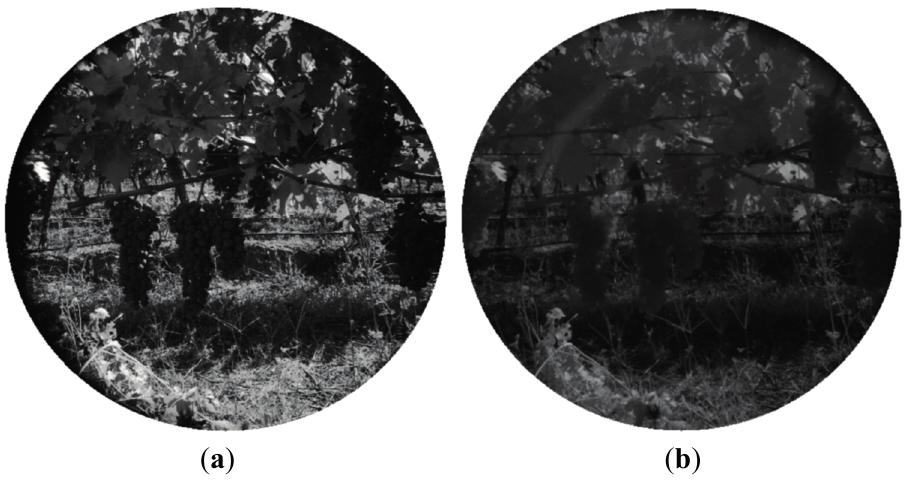
Figure 7. Vineyard – Filtered images. ( a ) 635 nm image; ( b ) 880 nm image.